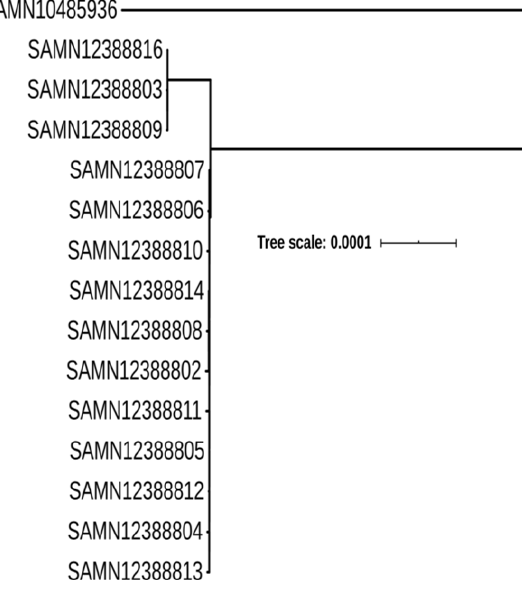
Figure 4. Phylogenomic relationship between 14 isolates linked with the outbreak in this study, and the only available genome ST2988 (SAMN10485936) in the NCBI database. The scale bar is at 0.0001.